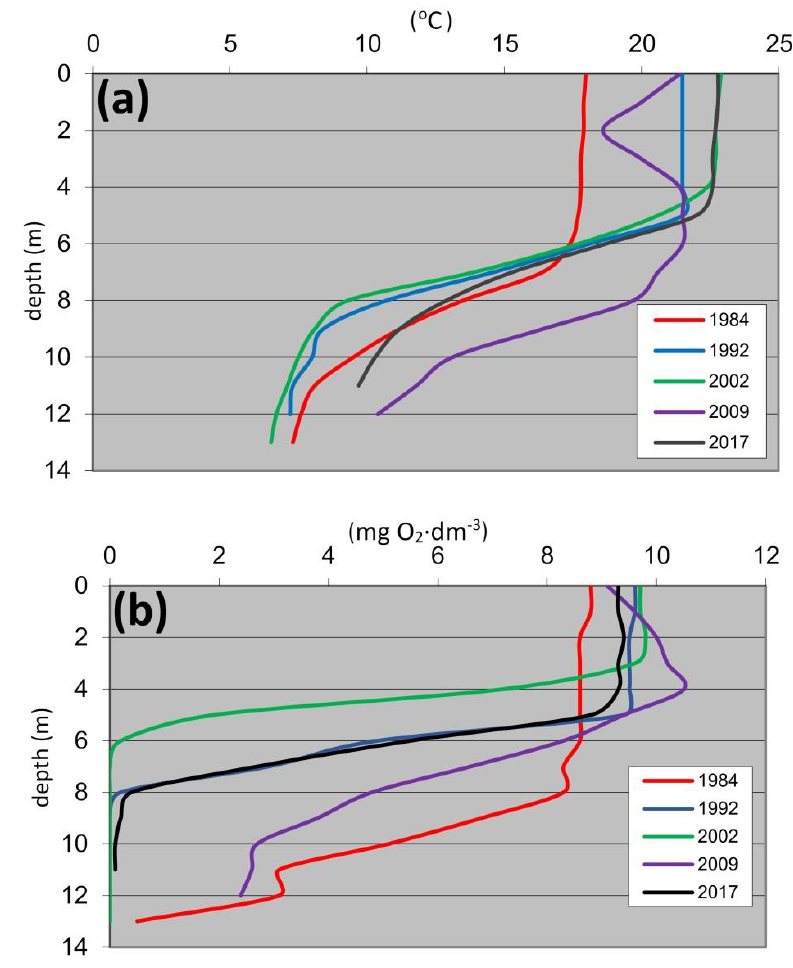
Figure 7. ( a ) Changes in water temperature t (°C) in the vertical profile of Lake Borówno between 1984 and 2017 at the end of summer thermal stratification; ( b ) Changes in dissolved oxygen content (mg·O 2 ·dm −3 ) in the vertical profile of Lake Borówno between 1984 and 2017 (prepared based on unpublished VIEP data).